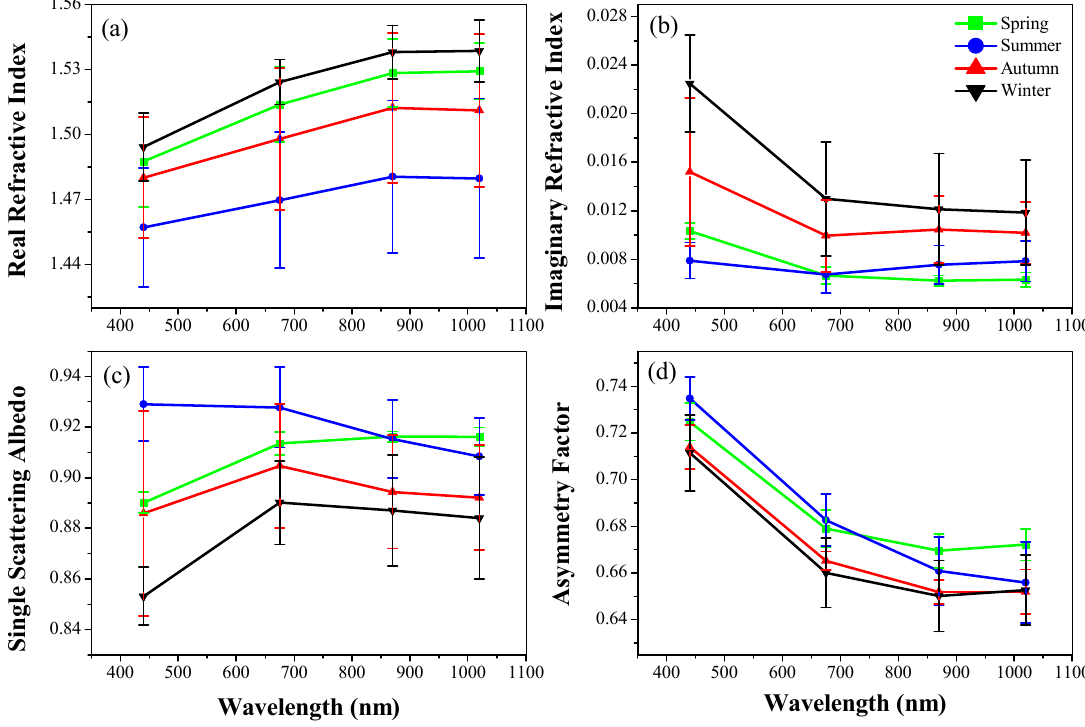
Figure 5. Seasonal average of spectral refractive index, including real ( a ) and imaginary parts ( b ), SSA ( c ), and asymmetry factor ( d ) over the Xi’an site. Error bars indicate the standard deviation of the monthly averages for the given season.